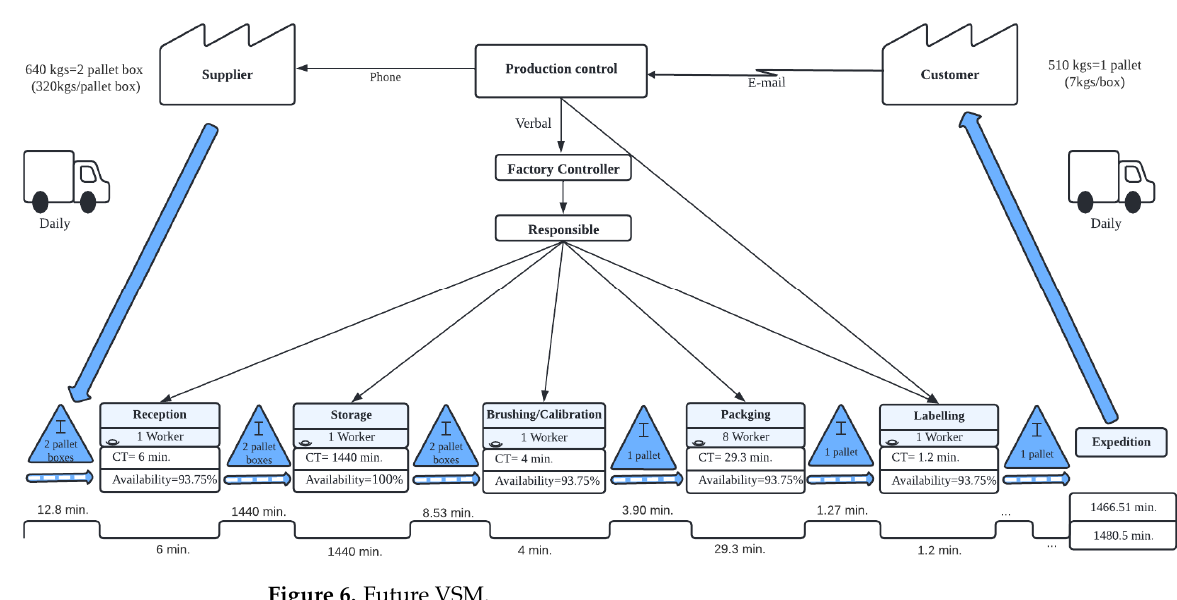
Figure 6. Future